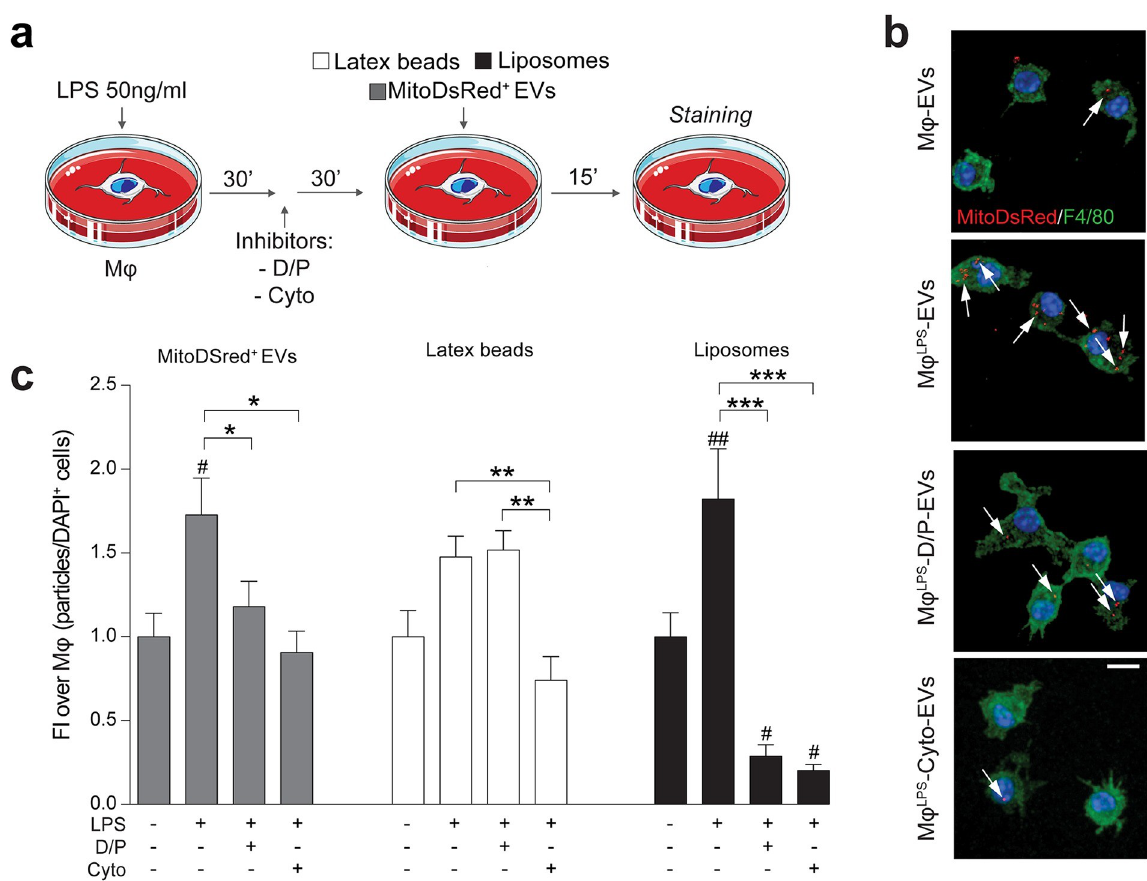
Fig 7. Pro-inflammatory mononuclear phagocytes uptake EV-associated mitochondria via endocytosis. (a) In vitro experimental setup of EV uptake studies in M φ LPS . M φ LPS were treated with either Cyto or D/P and then exposed to MitoDsRed + EVs (1:30). Latex beads and liposomes were used as positive controls of phagocytosis and endocytosis, respectively. (b, c) Representative confocal microscopy images (maximum intensity projection of Z-stacks) and quantification of MitoDsRed + EV (red) uptake in M φ LPS (stained for F4/80, green) in the presence or absence of endocytosis (D/P) and actin mediated phagocytosis/endocytosis (Cyto) inhibitors. Nuclei are stained with DAPI (blue). Data are mean FI over unstimulated M φ ( ± SEM) from N � 8 ROIs per condition. # p < 0.05, ## p < 0.01 vs. unstimulated M φ . � p < 0.05, �� p < 0.01, ��� p < 0.001. Scale bars: 10 μ m. (Data available in S3 Data). Cyto, Cytochalsin; D/P, Dynasore and Pitstop 2; DAPI, 4 0 ,6-diamidino- 2-phenylindole; EV, extracellular vesicle; FI, fold induction; LPS, lipopolysaccharide; ROI, region of interest.